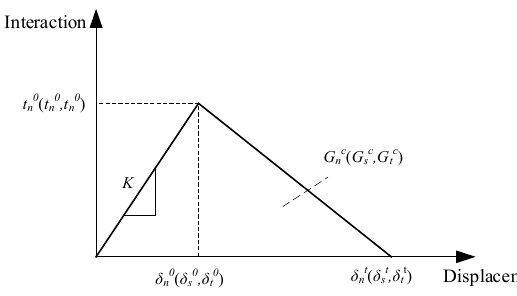
Figure 6. Cohesive model constitutive equation.